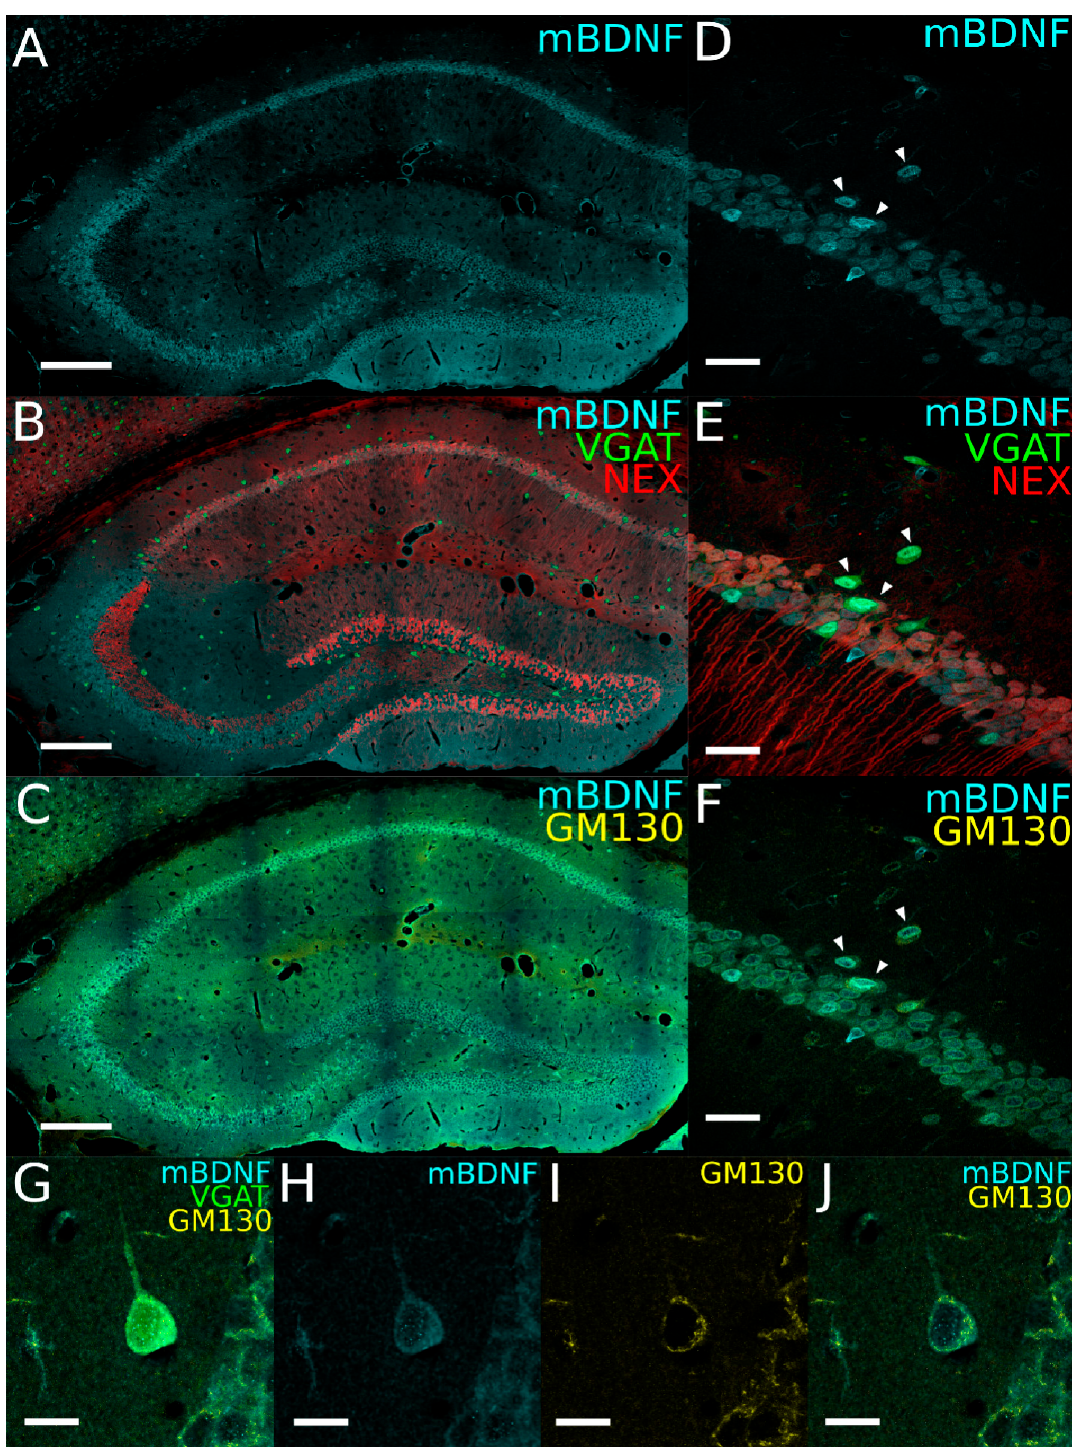
Figure 2. Expression of the mature form of brain-derived neurotrophic factor (mBDNF) in hippocampal glutamatergic and GABAergic neurons. ( A – C ) Immunostaining for mBDNF (cyan pseudocolor; A,B) and the Golgi marker, GM130 (yellow; C) in the dorsal hippocampus of VGAT-YFP x NexCre-Ai9 transgenic mice. ( D – F ) High-power confocal images from hippocampal CA1 area immunolabeled for mBDNF (D,E) and GM130 (F). Arrowheads indicate a cluster of YFP-positive GABAergic interneurons (INs; green), which are also labeled for mBDNF (D–F). ( G – J ) High-power confocal images from a hippocampal YFP-positive IN immunolabeled for mBDNF (G,H) and GM130 (I,J) (cyan and yellow, respectively) in the CA1 area from VGAT-YFP x NexCre-Ai9 transgenic mice (YFP signal in green). Note that the mBDNF signal is distributed throughout the somatic cytoplasm (H) and shows a partial colocalization with GM130 (J). Scale bars: (A–C), 200 µ m; (D–F), 30 µ m; (G–J), 10 µ